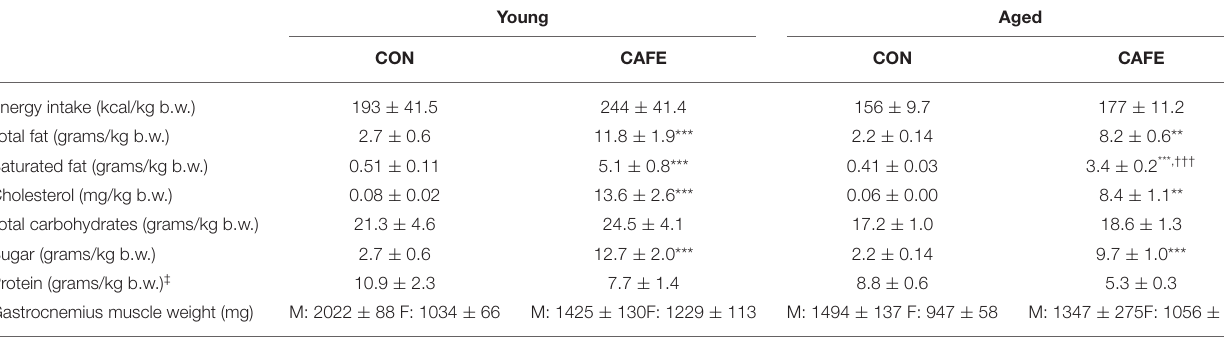
TABLE 2 | Daily nutrient intake and gastrocnemius muscle weights. Young Aged CON CAFE CON CAFE Energy intake (kcal/kg b.w.) 193 ± 41.5 244 ± 41.4 156 ± 9.7 177 ± 11.2 Total fat (grams/kg b.w.) Saturated fat (grams/kg b.w.) 3.4 ± 0.2 ***,††† Cholesterol (mg/kg b.w.) Total carbohydrates (grams/kg b.w.) Sugar (grams/kg b.w.) Protein (grams/kg b.w.)